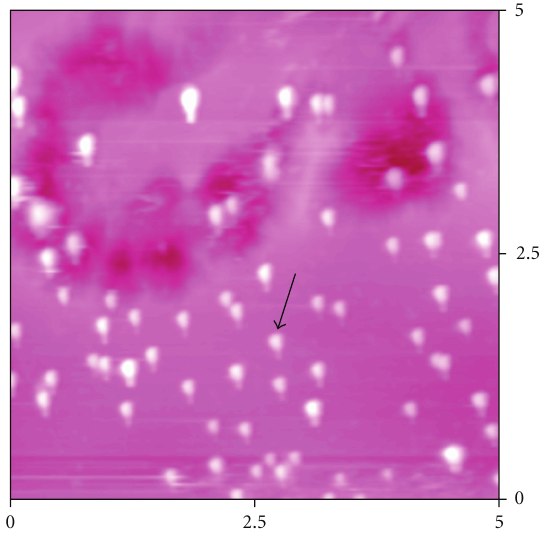
Figure 4: AFM image of hydroxyapatite